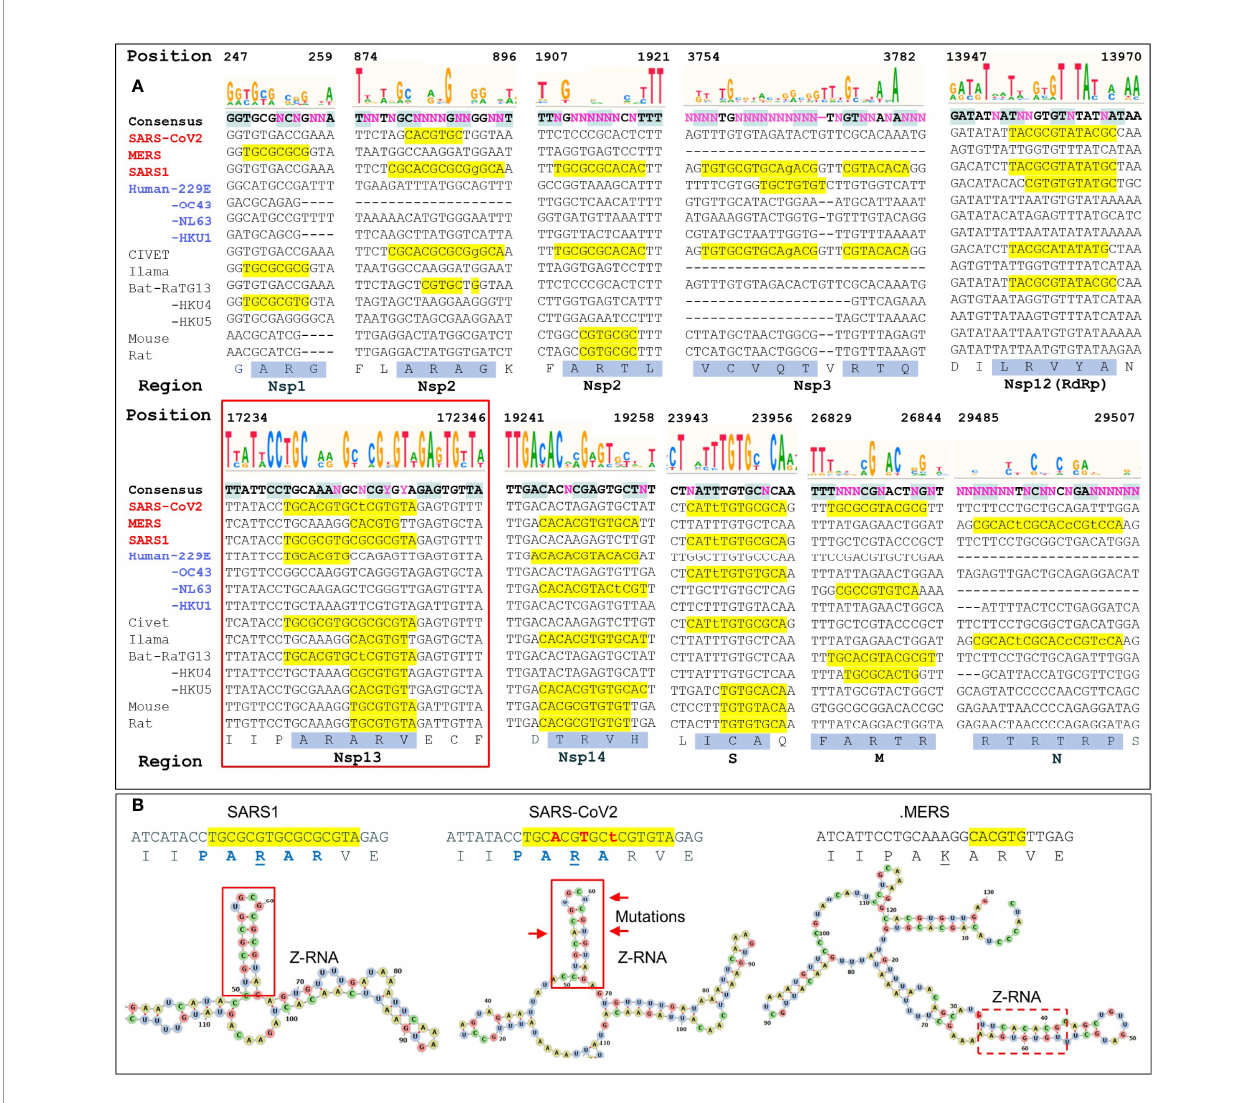
FIGURE 3 | Regions with high ZH3-scores (>600) (A) The multiple sequence alignment of coronaviruses to SARS-COV2 genome shows potential Z-forming elements in a number of regions of the coronavirus genome. Those encoding Nsp1, Nsp2 and Nsp3 and N proteins contain highly variable regions, while those for the RNA-dependent RNA polymerase (RdRp, Nsp12), the Nsp13 helicase (inside the red box) and the Nsp14 nuclease/methyl-transferase show greater constraint. Lower case letters indicate bases that break the pyrimidine/purine alternation. The amino acid translation of the fi rst and longest nucleotide sequence with a yellow background are highlighted with a blue background. Nucleotide positions are numbered by the SARS-COV2 genome. (B) Compared to SARS1, the helicase of SARS-CoV2 contains three adjacent non-synonymous mutations that conserve the Z-RNA stem and the peptide sequence, but diminish its Z-forming potential. The equivalent MERS sequence has a very low Z-forming potential and encodes a peptide with a lysine (K) in place of an arginine (R). A potential MERS Z-RNA prone element is close-by (within the dashed